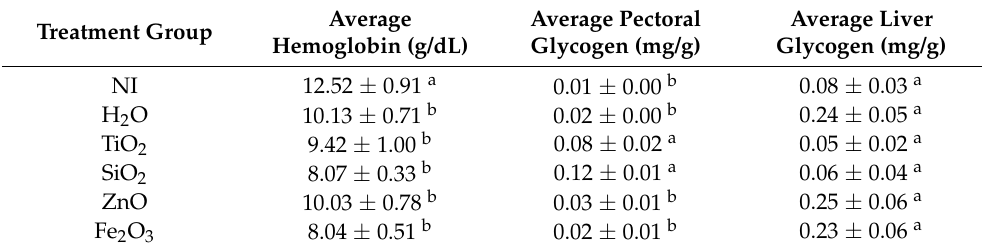
Table 4. Blood hemoglobin concentrations (g/dL) and pectoral muscle glycogen concentrations (mg/g) following genistein exposure 1